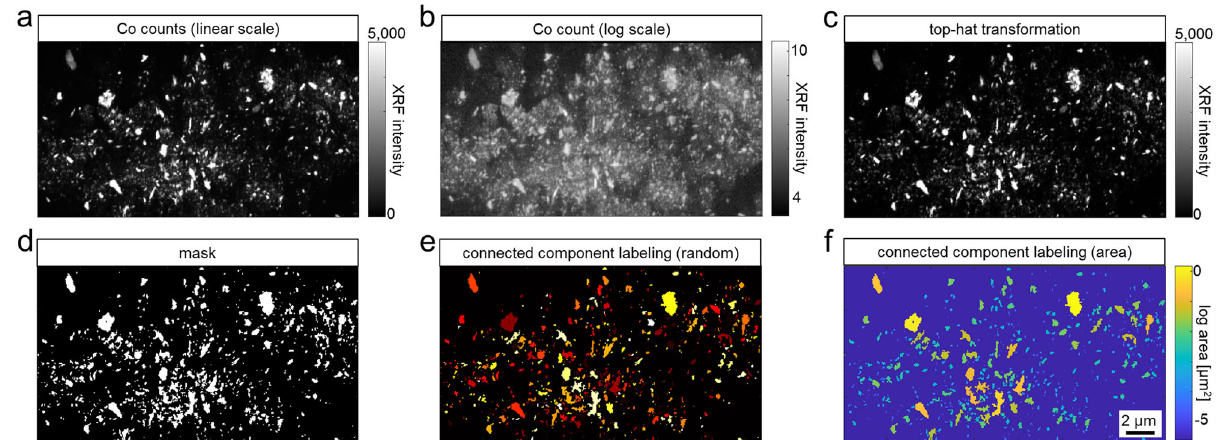
Fig. 2 Representative work fl ow for data processing of the nano-XRF map of periprosthetic bone marrow from a patient with hip resurfacing implant. a , b Linear scale and log scale maps of the spatial Co signals. c Linear scale map of the spatial Co signal following top-hat